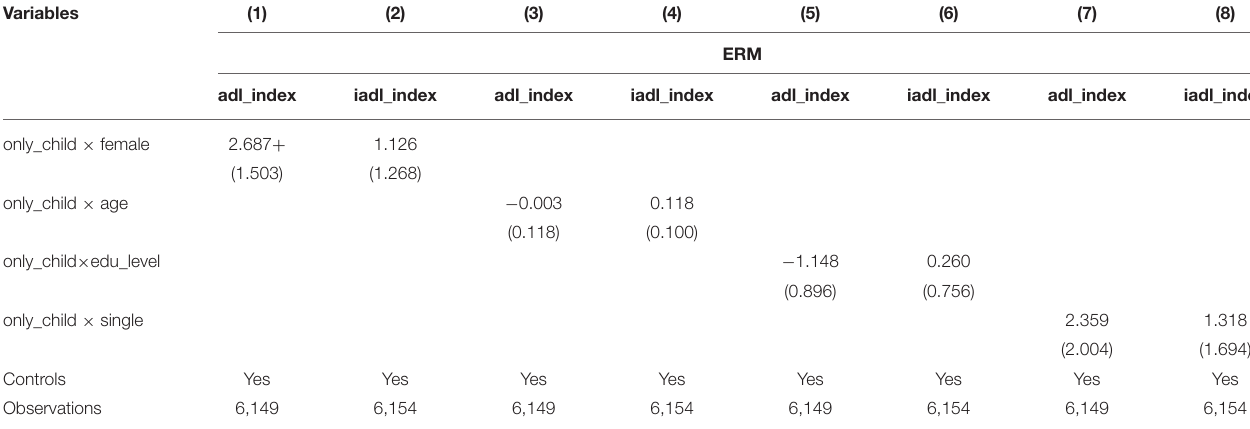
TABLE 4 | The heterogeneous analysis. Variables